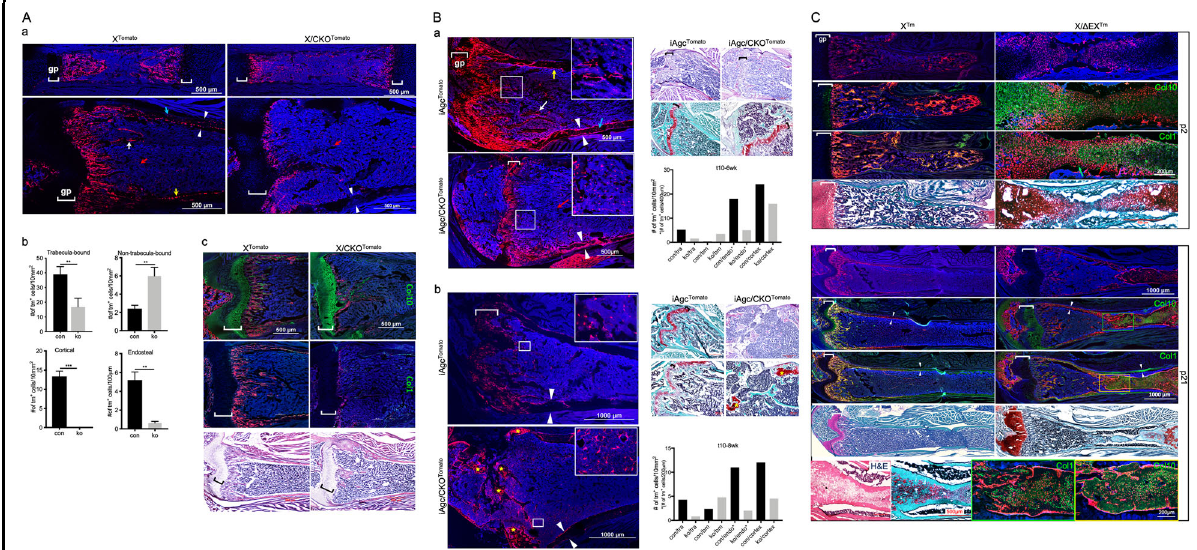
Fig. 1 Histological characterization of X/CKO Tomato , iAgc/CKO Tomato , and X/ Δ EX Tomato mice. A : a Confocal images of the p2 (upper) and p16 (lower) femurs. b Quantitative comparisons of Cre-induced Tm + cells categorized by distribution between p16 X Tomato (con) and X/CKO Tomato (ko) mice, n = 3, ** p < 0.01, *** p < 0.001. c Confocal images of p16 femurs: anti-Col10 and anti-Col1 IF (green) and H&E staining. gp growth plate. White arrow: trabecula-bound Tm + cell; red arrow: non-trabecula-bound Tm + cell; blue arrow: cortical Tm + cell; yellow arrow: endosteal Tm + cell. White arrowheads designate cortices. B p10 iAgc/CKO Tomato mutant and iAgc Tomato control mice were injected with tamoxifen and sacri fi ced after 6 weeks ( a ) and 8 weeks ( b ). a , b Left: confocal images of the femurs. Right top: H&E (upper) and Saf-O (lower) staining; b Right bottom: quantitative comparisons of Cre-induced Tm + cells between iAgc Tomato (con) and iAgc/CKO Tomato (ko) mice. Yellow asterisk: cartilage . C Confocal and Saf-O images of the p2 humeri and p21 femurs of X Tomato and X/ Δ EX Tomato mice. Boxed areas are shown in corresponding magni fi ed images below. Green arrow: indicating Col1 staining lining the mineralized rod. Red arrow: indicting Tm + Chon-obs adjacent to the rod. White arrowheads: denoting